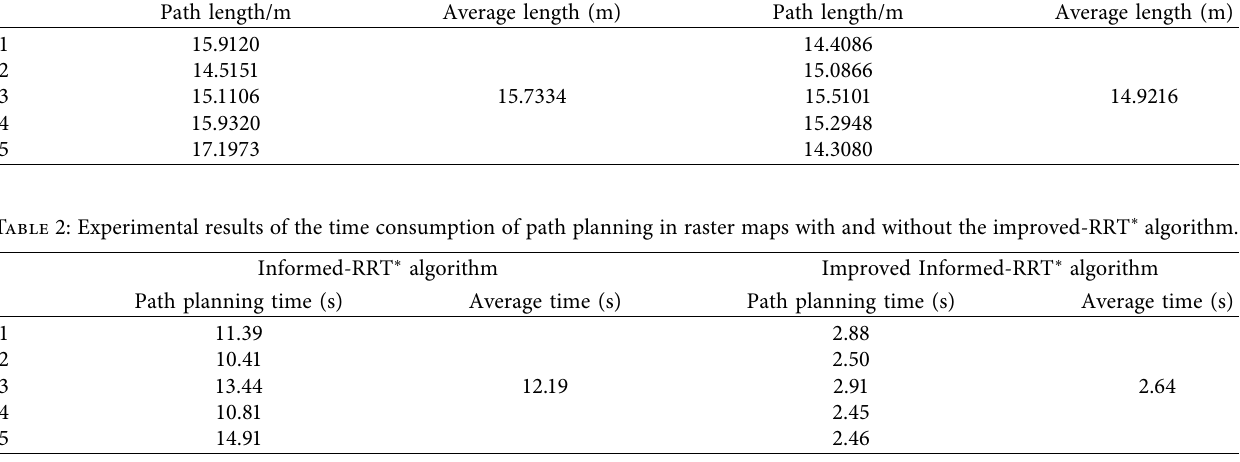
Table 1: Experimental results of path length planning in raster maps using the improved Informed-RRT ∗ algorithm. Informed-RRT ∗ algorithm